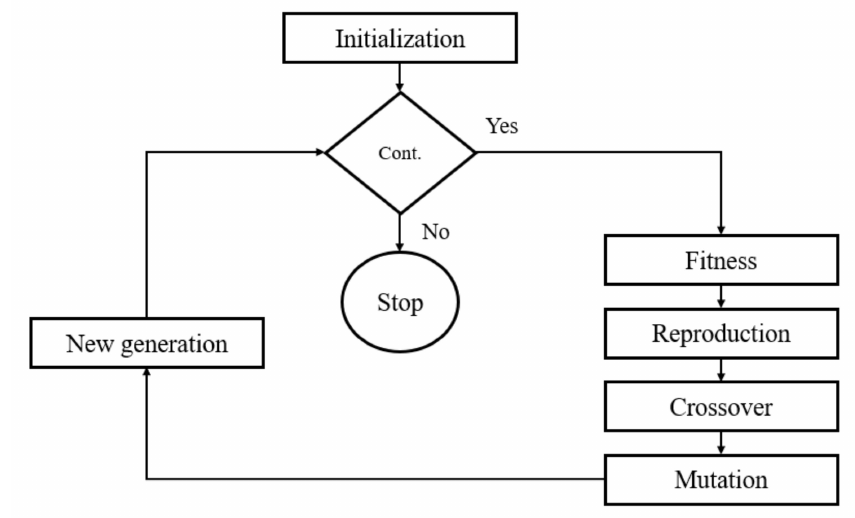
Figure 3. Genetic